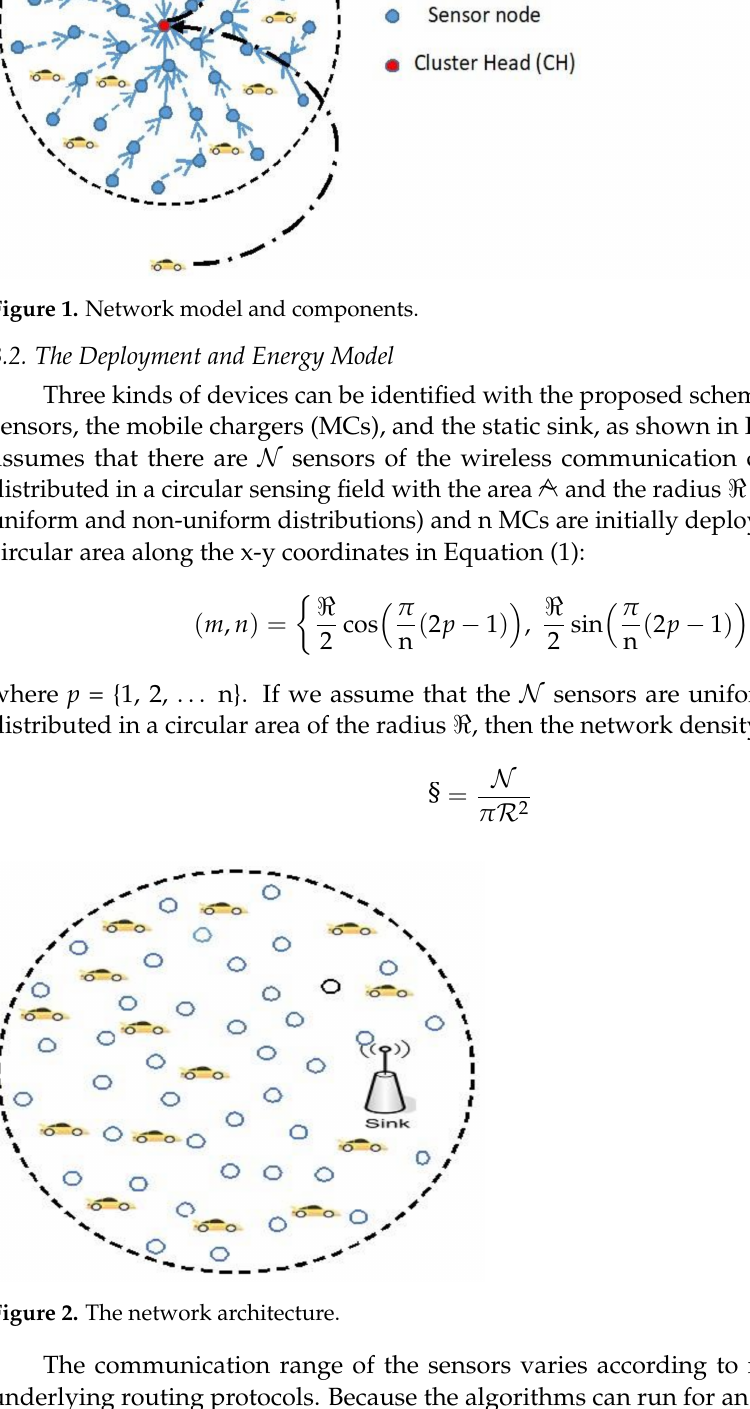
Table 1. Notations with their descriptions.